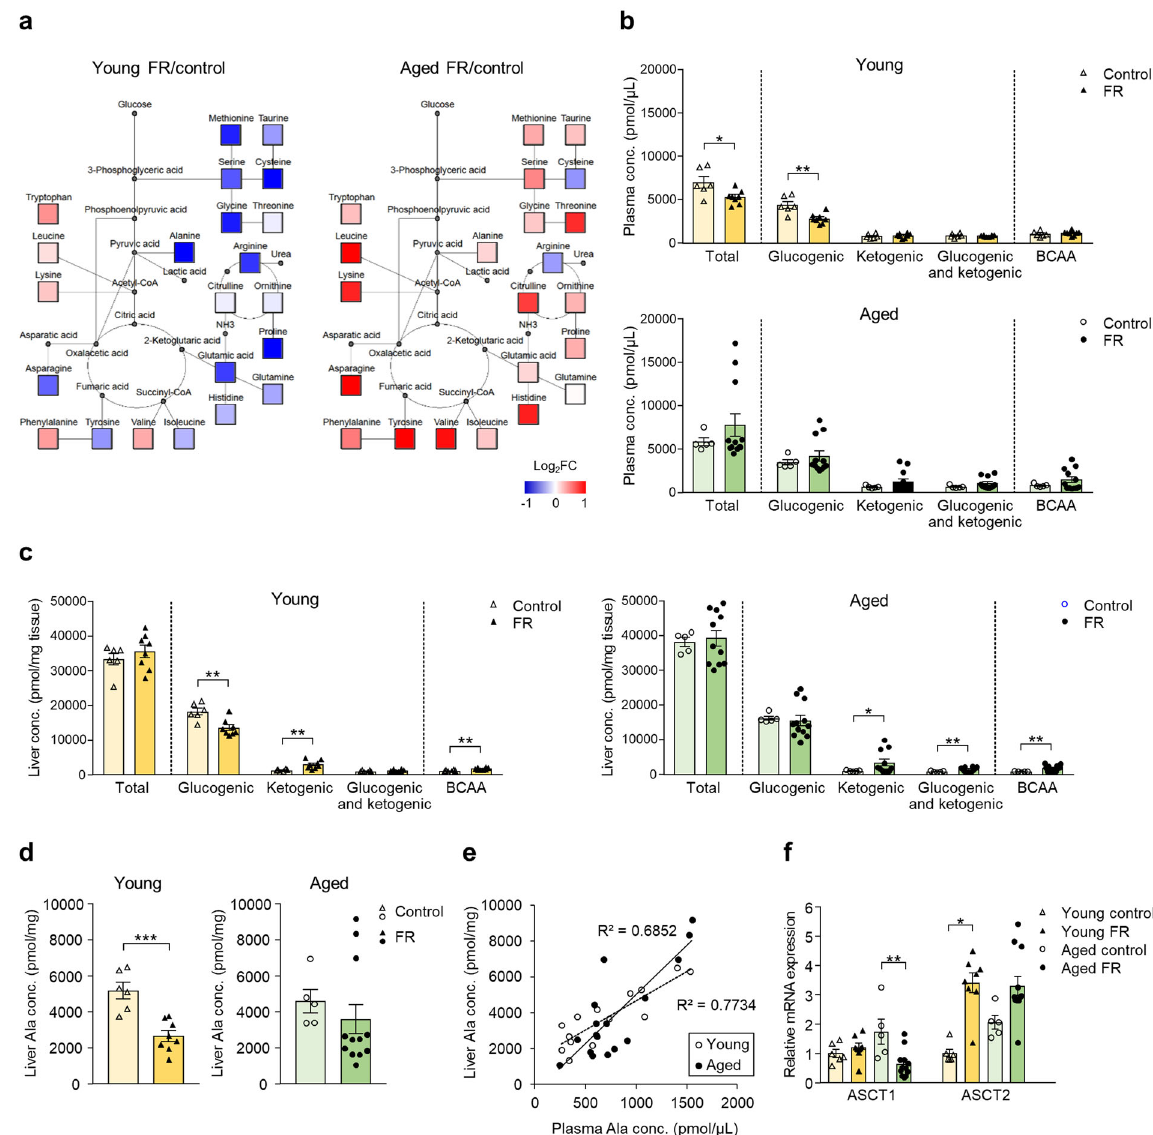
Fig. 3 Amino acid pro fi le on day 5 of food restriction. a Amino acid metabolic pathway map in young and aged mice all subjected to food restriction (FR). Mean ratio of plasma amino acid levels in FR mice to control mice is shown according to the color scale. Red color represents upregulation and blue color represents downregulation compared to the mean value of age-matched control. Undetected amino acids and key metabolites are shown with small gray circles. b Plasma concentration of amino acids. * P < 0.05, ** P < 0.01 vs. age-matched controls by Student ’ s or Aspin – Welch t test. c The liver concentration of amino acids. * P < 0.05, ** P < 0.01 comparison to age-matched controls by the Student ’ s or Aspin – Welch t test. d Liver alanine concentration. *** P < 0.001 comparison to the control by the Student ’ s t test. e The correlation between liver and plasma alanine concentration in young and aged and control and FR mice. f Hepatic gene expression of Slc1a4 , encoding alanine – serine – cysteine transporter (ASCT) 1, and Slc1a5 , encoding ASCT2, in the young and aged FR mice. * P < 0.05, ** P < 0.01 by the Tukey − Kramer or Steel − Dwass test. Young control ( n = 6), young FR ( n = 8), aged control ( n = 5), and aged FR ( n = 12). Data are presented as mean ± SEM ( b , c , d , and f